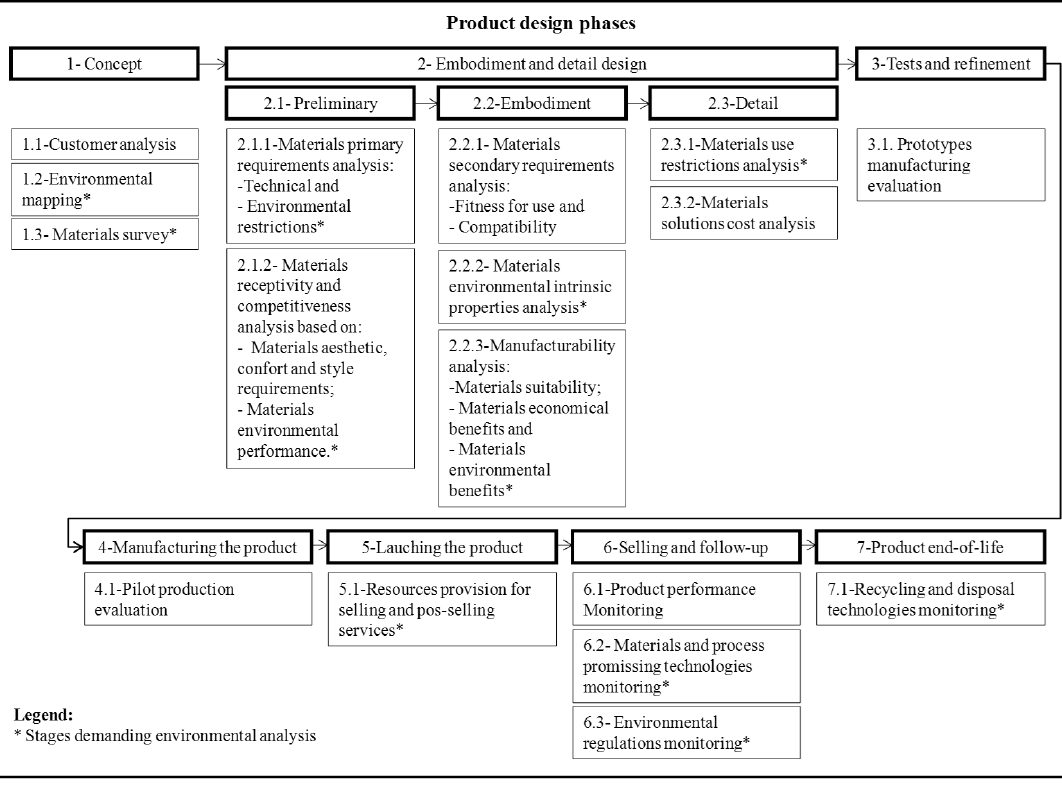
Figure 5: Roadmap of materials selection needed in product development for environmentally friendly